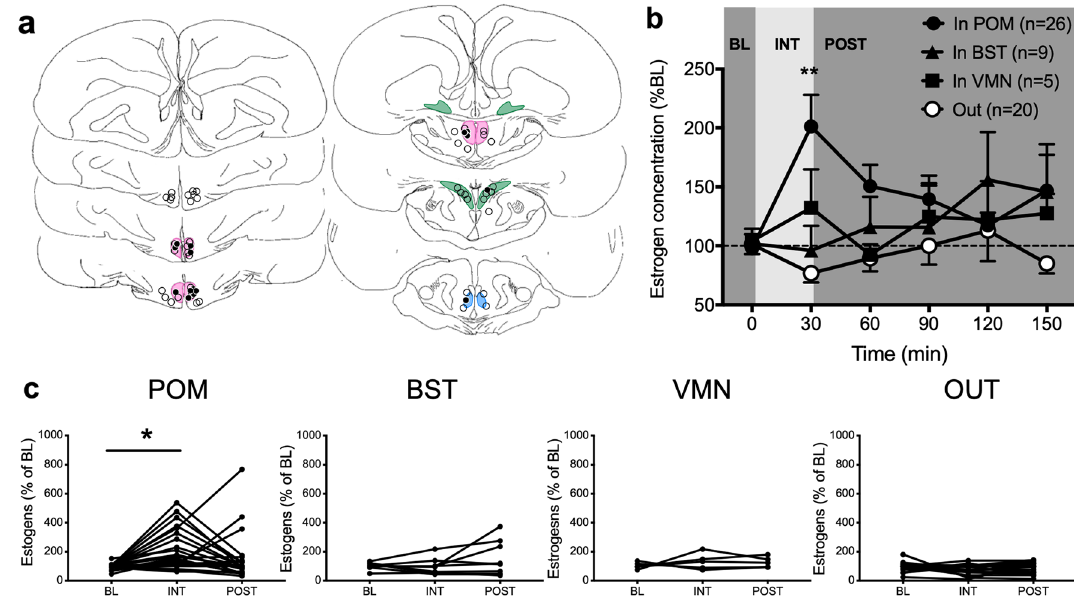
Figure 3. Local estrogen concentrations increase in POM but not in other brain regions during sexual interactions. ( a ) Schematic representation of coronal sections of the quail brain showing the location of the dialysis probes. IN probes are either within or touching the colored zones representing brain regions expressing aromatase. See legend of Fig. 1 for the definition of different brain areas. Black and open circles respectively represent birds in which estrogen concentrations did or did not increase above 150% of the baseline (BL) during the interaction period (last sample of each experimental condition). ( b ) Mean percent changes of estrogen concentration in the dialysate over time following a sexual interaction (based on the mean concentration measured in the last 2 BL samples). OUT: Birds with a cannula outside any aromatase expressing cell populations. INT: physical interaction with the female, POST: post-interaction period. Only males with a cannula in the POM showed a significant rise in estrogens peaking during the interaction period and then gradually decreasing (Friedman ANOVAs: POM, χ 2 n=26 = 18.90, p = 0.002; BST, χ 2 n=9 = 3.591, p = 0.6097; VMN, χ 2 χ 2 n=5 = 3.2187, p = 0.6664; OUT, n=20 = 4.4274, p = 0.5100; post hoc **p < 0.01 vs BL). ( c ) Individual percent changes in estrogen concentration relative to BL in the last time point of the three sampling periods for animals whose probe was placed in POM, BST or VMN, or outside a nucleus expressing aromatase (OUT). (Friedman ANOVAs: POM: χ 2 n=26 = 10.17, p = 0.0062; BST: χ 2 n=9 = 0.7879, p = 0.7065; VMN: χ 2 n=5 = 0.4, p = 0.9537; OUT: χ 2 n=20 = 5.733, p = 0.0569; post hoc *p < 0.05 vs BL). The baseline amounts of estrogens per sample in this experiment ranged between 0.023 and 1.390 pg per sample (10 µl; Mean ± S.E.M. = 0.201 ± 0.034, n = 60). Panel A is composed of home made drawings onto which probe positions were reported using Graphic for Mac (https:// graph ic. com/ mac/), other panels were created with Graph Pad Prism 8 (https:// www. graph pad. com/ scien tific- softw are/ prism/). All panels were assembled in